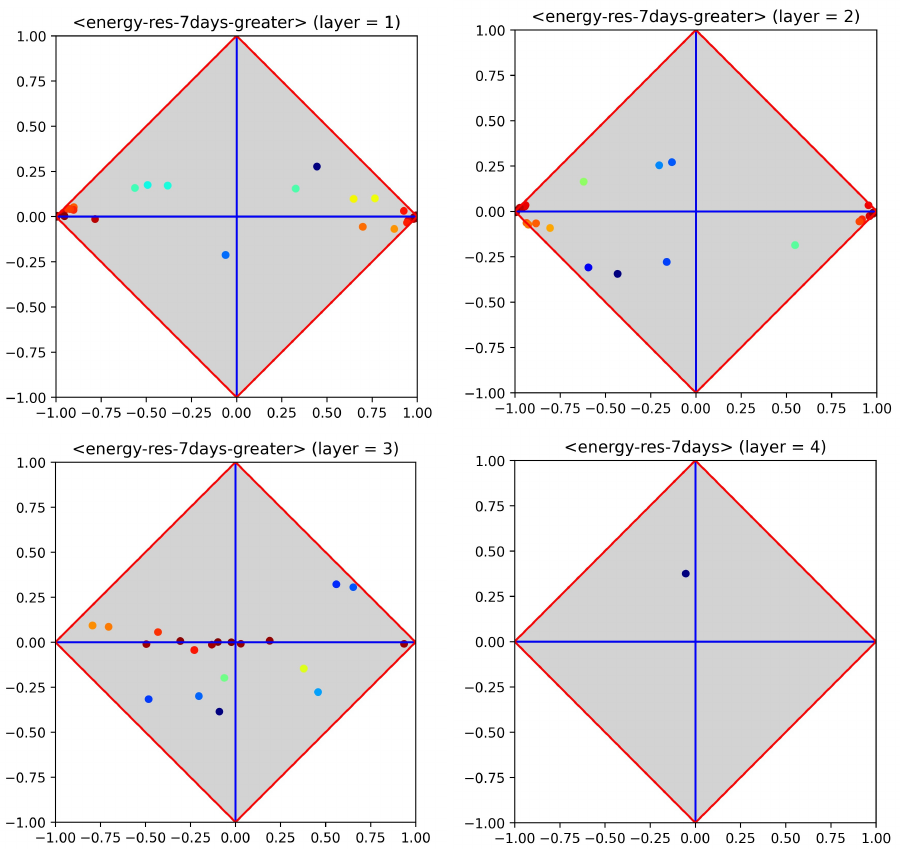
Figure 4. Hidden layers of an MLP trained on the dataset relating to residential customers (full set of features). The focus was on predicting whether the next-hour load would be greater than the previous